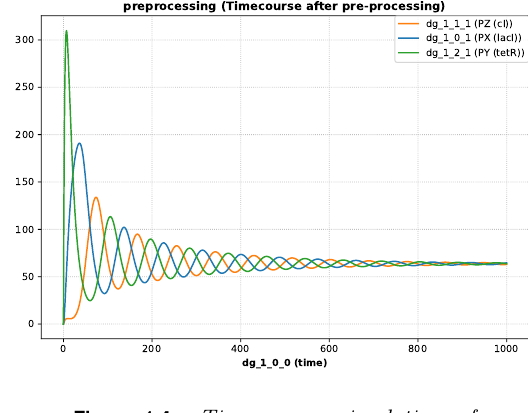
Figure 1.4: Time-course simulation of the repressilator after changing param- eters tps repr and tps active . Simula- tion with tellurium [6].